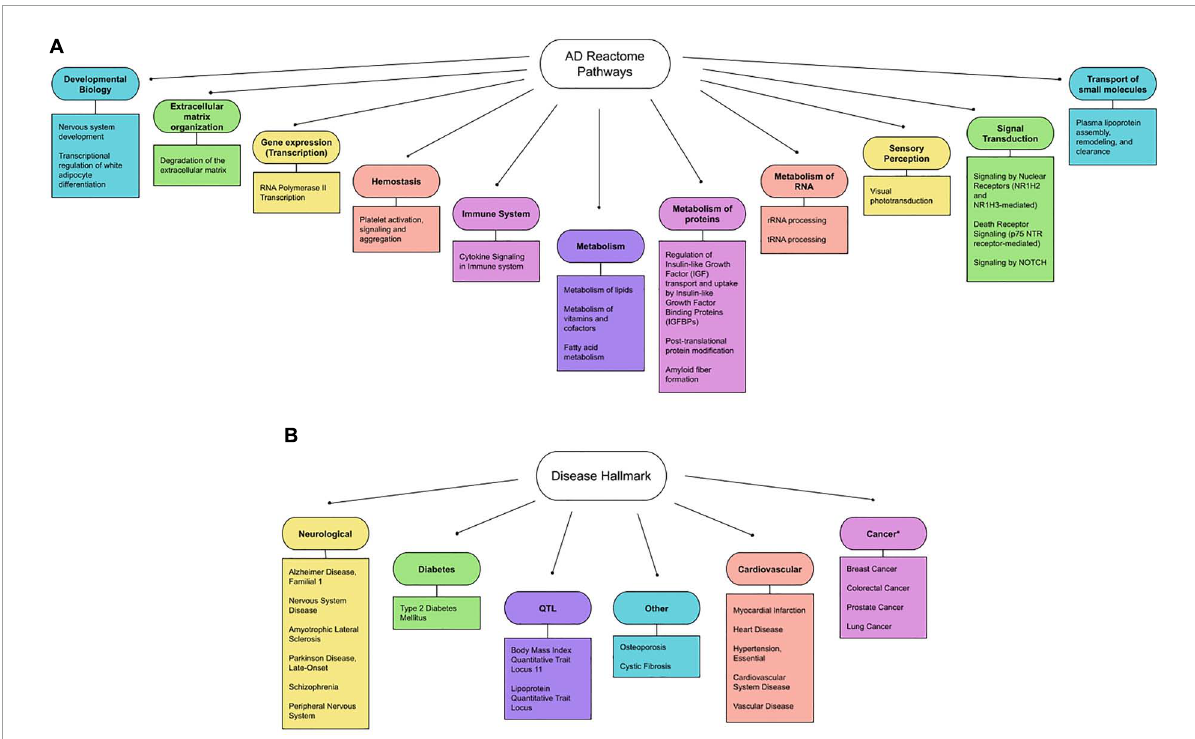
FIGURE2 (A) Updated biological hallmarks. We extended the list indicated by Table 1 , using the threshold ( p -value < 1.00E-05) and summarized the 11 general biological hallmarks (circle) and more specific hallmarks (square). (B) Updated disease hallmarks. The diseases listed in Table 2 are organized and grouped into 6 general disease criteria. They are further classified into: (1) neurological diseases (Alzheimer’s Disease, Familial, 1, Amyotrophic Lateral Sclerosis 1, Parkinson’s Disease, Late-Onset, Schizophrenia, Peripheral Nervous System Disease, Nervous System Disease, others); (2) common age-related diseases (Diabetes, Cardiovascular Disease, Cancer and Osteoporosis); and (3) other diseases (Quantitative Trait Loci and Cystic fibrosis). Note that cancers are reported to show an inverse relationship with AD genes (indicated by asterisks).